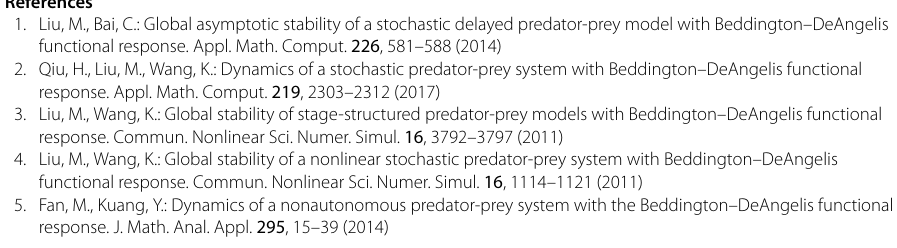
and prey was considered. By employing the Lyapunov–Krasovskii method and the graph- theoretical technique, a stability criterion was derived. Finally, an example with numeri- cal simulation was given to demonstrate the effectiveness of the obtained results. Because noise disturbance in our real life is ubiquitous [28–30], in the future, we will try to take the effect of noise disturbance into our